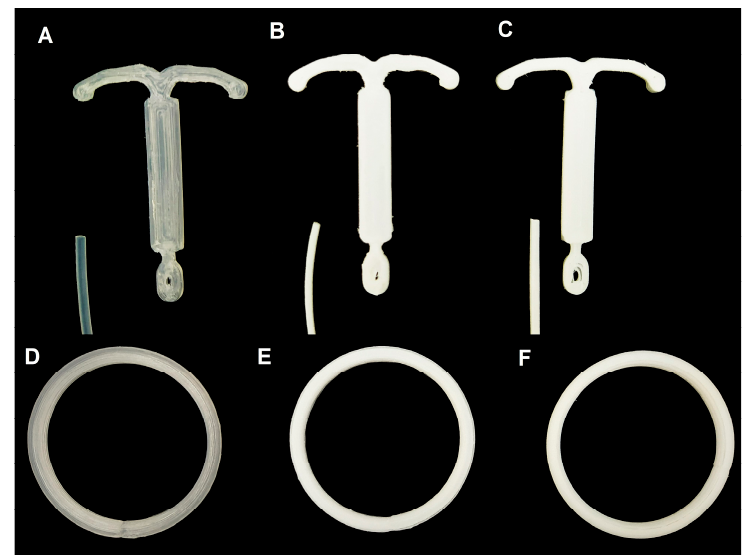
Figure 1. IUDs ( top ) and intravaginal rings ( bottom ) manufactured by fused filament fabrication using pure EVA ( A , D ) and EVA/ACV with 10 wt.% ( B , E ) and 20 wt.% ( C , F ) of acyclovir.